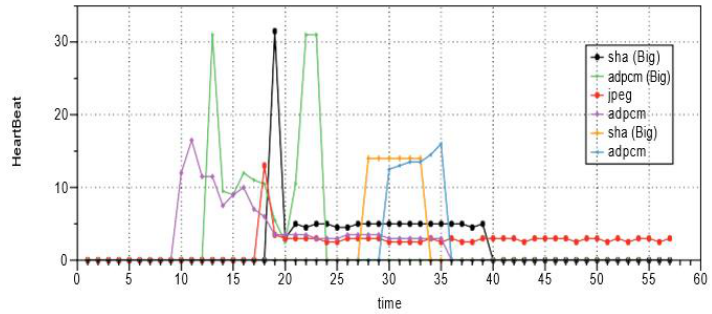
Figure 12. Application performance over Odroid node 0.